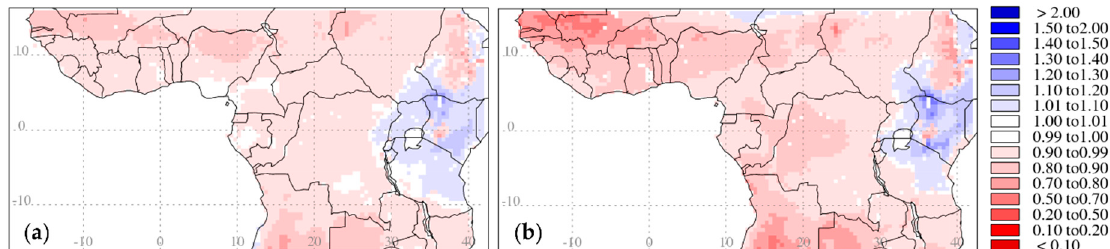
Figure 5. Increase factor of soil water (i.e., the ratio of average available soil water amounts between the annual average over the 2080–2099 period and the reference 1980–1999 period). The values correspond to the ensemble mean of the results obtained with the seven climate projections under ( a ) the RCP4.5 and ( b ) the RCP8.5 scenarios, and a variable CO 2 mixing ratio (CO 2 [var]